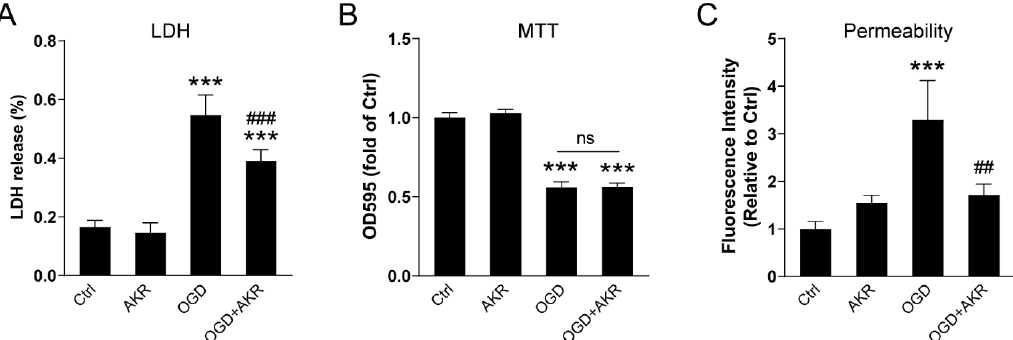
Figure 7. AKR1C15 protected BMVECs against OGD-induced cell death and BBB leakage. Primary rat BMVECs were subjected to 12 h OGD followed by reoxygenation in the presence or absence of 10 µg/mL TAT-AKR1C15. Cell viability and death were evaluated by ( A ) LDH assay and ( B ) MTT assay at 8 h after reoxygenation. In vitro BBB model was applied, and ( C ) permeability was evalu- ated at 6 h after reoxygenation. Data are mean ± SD. n = 4 independent experiments. One-way ANOVA followed by Tukey’s multiple comparison. *** p < 0001 vs. Ctrl. ##, ### p < 0.01, 0.001 vs. OGD. ns: not significant. BMVEC: brain microvascular endothelial cells. OGD: oxygen–glucose dep- rivation. LDH: lactate dehydrogenase. MTT: 3-(4,5-dimethylthiazol-2-yl)-2,5-diphenyltetrazolium bromide. BBB: blood–brain barrier.